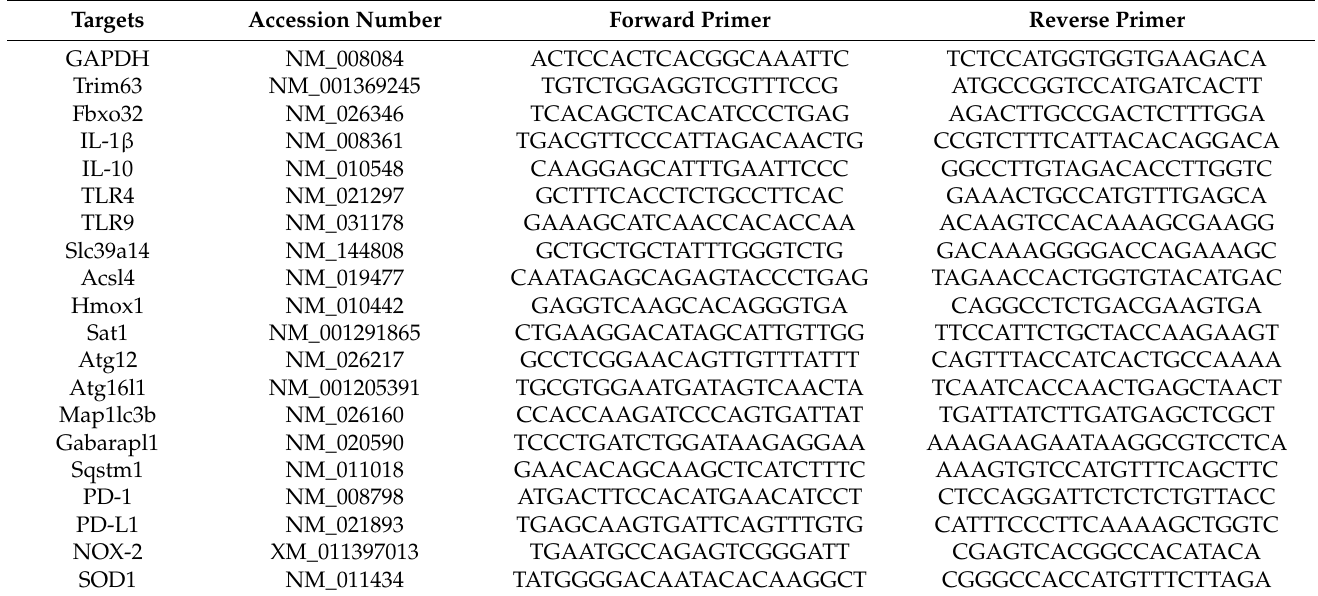
Table 1. Primer sequences of RT–qPCR.